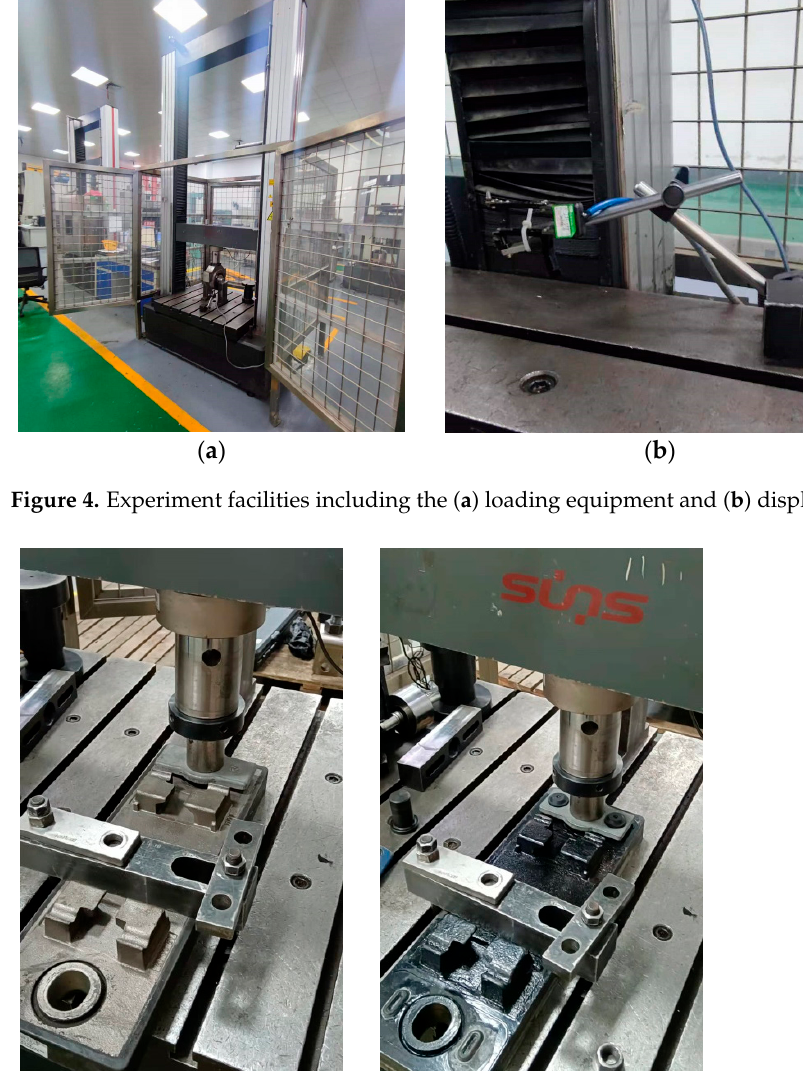
Figure 4. Experiment facilities including the ( a ) loading equipment and ( b ) displacement sensor.